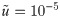
Occupancy profiles of clones show the reduced prominence of the core with increased long-range dispersal.(a) Ensemble-averaged occupancy profiles of mutant clones in 1D, with L = 106 and u˜=10-5. The occupancy profile of a particular clone is defined as the probability ρ(r) that a deme at distance r from its point of origin is occupied by that clone. Colours signify different dispersal kernels, with exponents μ = {0.4, 0.6, 0.8, 1, 1.2, 1.4, 1.6, 1.8, 2, 3} in order of increasing occupancy at the origin. Curves are obtained by averaging individual occupancy profiles from all clones with total mass X > 100 to obtain a range-averaged occupancy profile 〈ρ〉 for each of 100 independent simulations for each dispersal kernel; these were then averaged to obtain the ensemble-averaged profile 〈ρ¯〉. Inset illustrates the origin of the variation in occupancy for r/req < 2 in the wavelike growth regime: the mutational origin need not be positioned at the centre of mass of the contiguous domain, giving rise to a single-clone occupancy profile ρ(r) = {1, 0 < r ≤ r1; 1/2, r1 < r ≤ r2; 0, r > r2}. (b) Same data as in (a) on logarithmic scales. The dashed lines show the power-law dependence 〈ρ〉 ∝ r−(μ+d). (c) Core occupancy, defined as the fraction of the ensemble-averaged occupancy that lies within 0 < r/req < 2, as a function of kernel exponent μ.